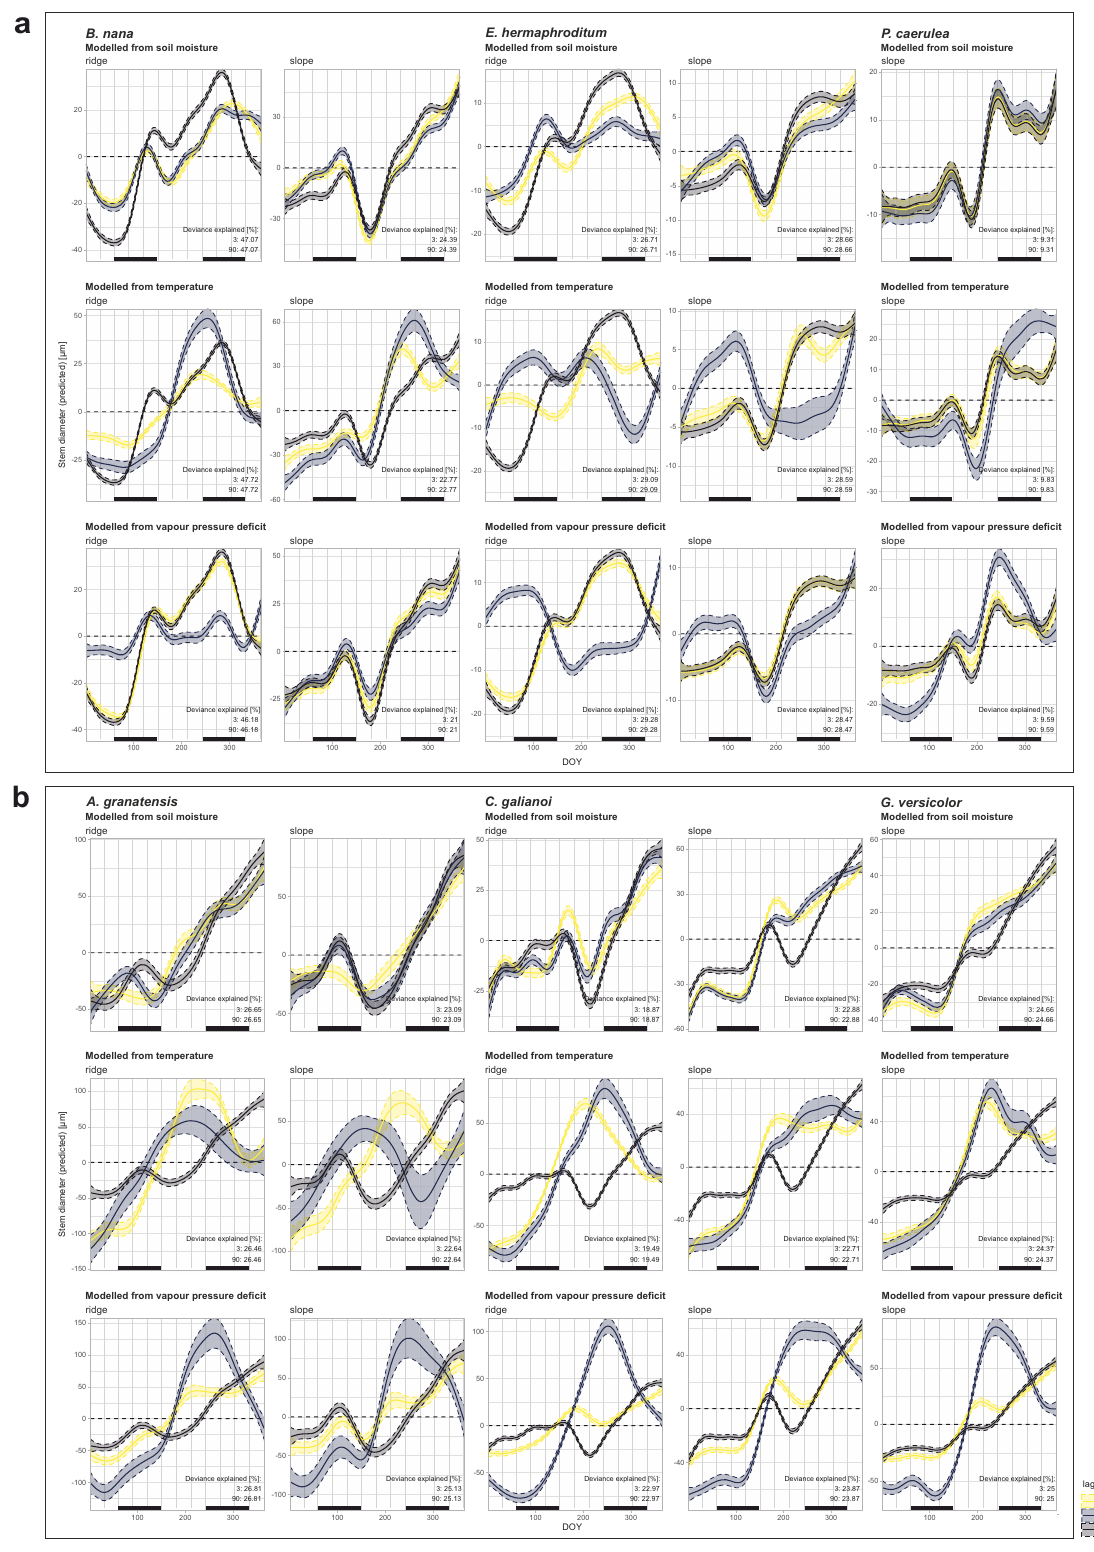
Fig. 3 Intra-annual stem diameter change predicted by distributed lag non-linear models (DLNMs) implemented with generalized additive models (GAMs). Models for the tundra ( a ) and Mediterranean species ( b ) incorporate delayed environmental effects (soil moisture, temperature, and vapour pressure de fi cit) as distributed lag non-linear models (DLNMs). Colours indicate delay time spans included in the DLNMs (lag). Bars at the bottom of each graph show meteorological seasons. Coloured areas show the 95%-con fi dence